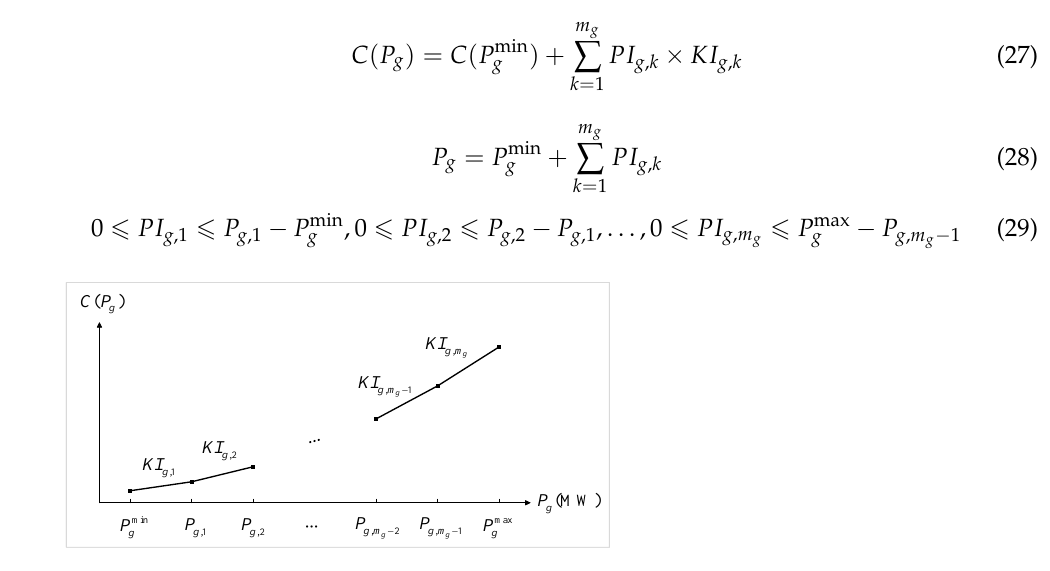
Figure 2. The linearized cost curve of generator g .